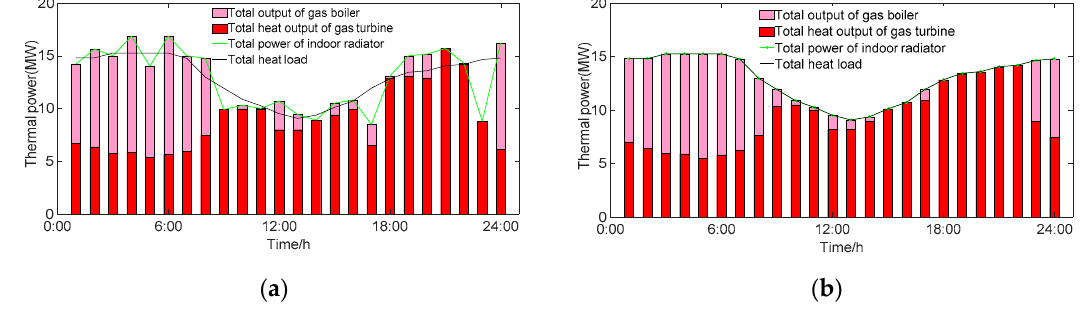
Figure 15. Heat power balance. ( a ) T c = 3 h. ( b ) T c = 1 h.